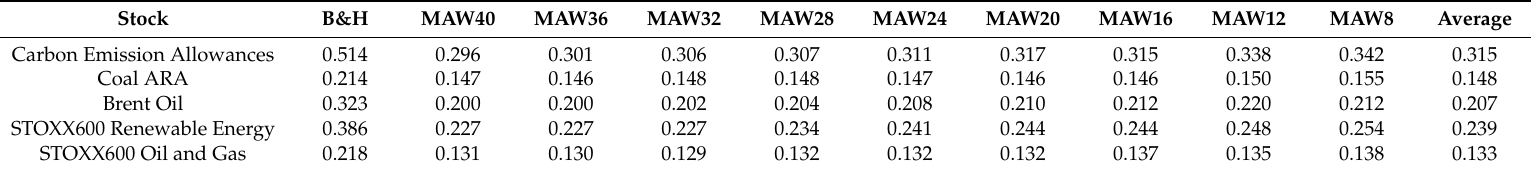
Table A9. Annualized daily (every fifth trading day) volatility of MAW8–MAW40 (W = number of weeks), average annualized volatility.